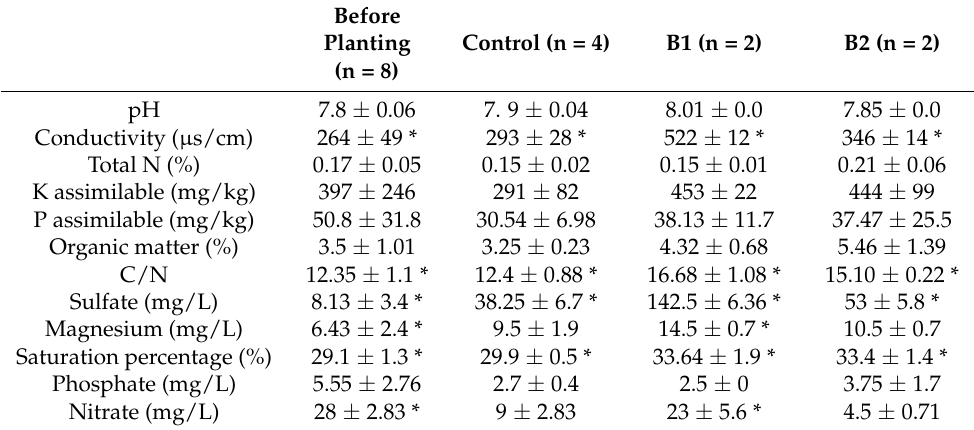
Table 2. Number of macronutrients and soil characteristics in soil before and after planting. Control: plots without biochar; B1: plots supplemented with biochar B1; B2: plots supplemented with biochar B2. Before